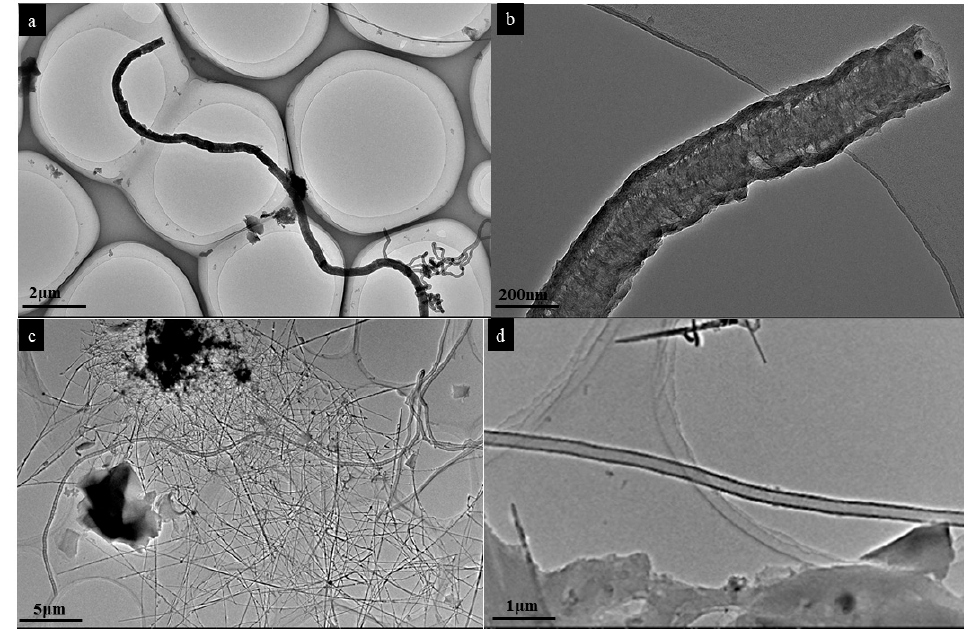
Figure 4. HRTEM images of CNTs after microwave treatment: ( a ) 1200 °C, ( b ) magnified image of ( a ), ( c ) 1300 °C, ( d ) magnified image of ( c ).